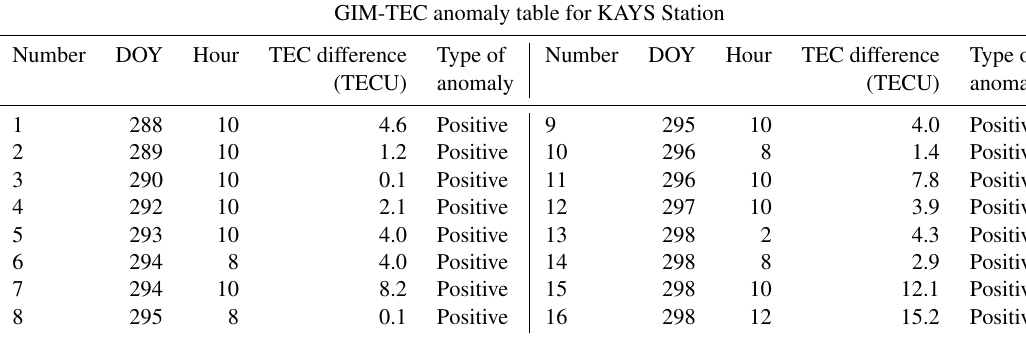
Table 6. BING Station GIM-TEC anomaly table.